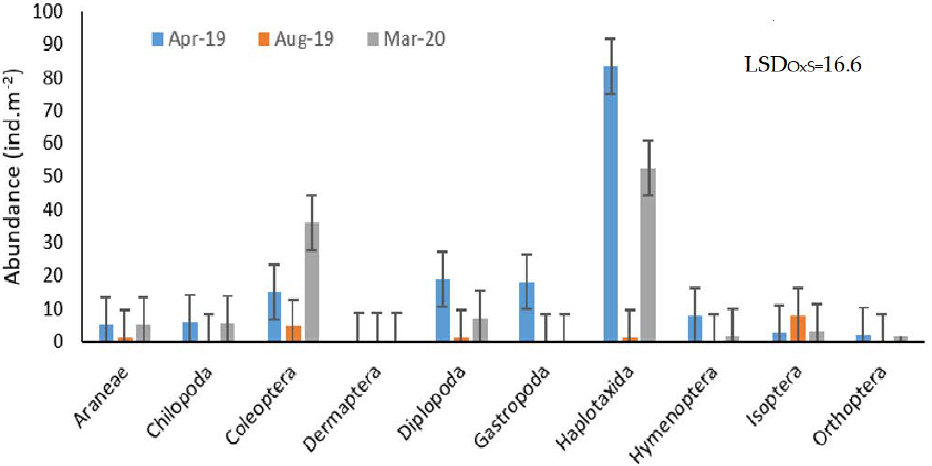
Figure 7. Variation in abundance of the different taxonomic groups across the three sampling times (April 2019, August 2019 and March 2020) after 17 years of trial establishment. O = orders and S = sampling time. The repeated measures ANOVA results (Table 7) indicated that all indices of soil macrofauna communities responded significantly to treatments ( p < 0.001), N fertiliser ap- plication rates ( p < 0.001), time of sampling and their interactions ( p < 0.001). In CT treat- ment, there were no significant ( p > 0.05) differences found in macrofauna diversity ( H’ ) (Figure 8) and evenness (E) (Figure 9) across the three sampling times, and soil macrofauna community or diversity was not affected by the N fertiliser application rate. Contrarily, in the NT and RT treatments, H’ and E of macrofauna were highly affected by sampling time (Figures 8 and 9). Nitrogen fertiliser in these treatments, i.e., 100 kg/ha, significantly reduced the presence of certain species. However, the types of macrofauna communities found in April 2019 and March 2020, which correspond to the summer and rainy season, respectively, were similar ( p > 0.05) compared to the August 2019 sampling period, which corresponds to winter with no rain. Table 7. The results of repeated ANOVA of the effect of tillage treatments, N fertiliser application rate, and sampling time on Shannon – Weiner and Evenness indices. Shannon – Weiner ( H’ )